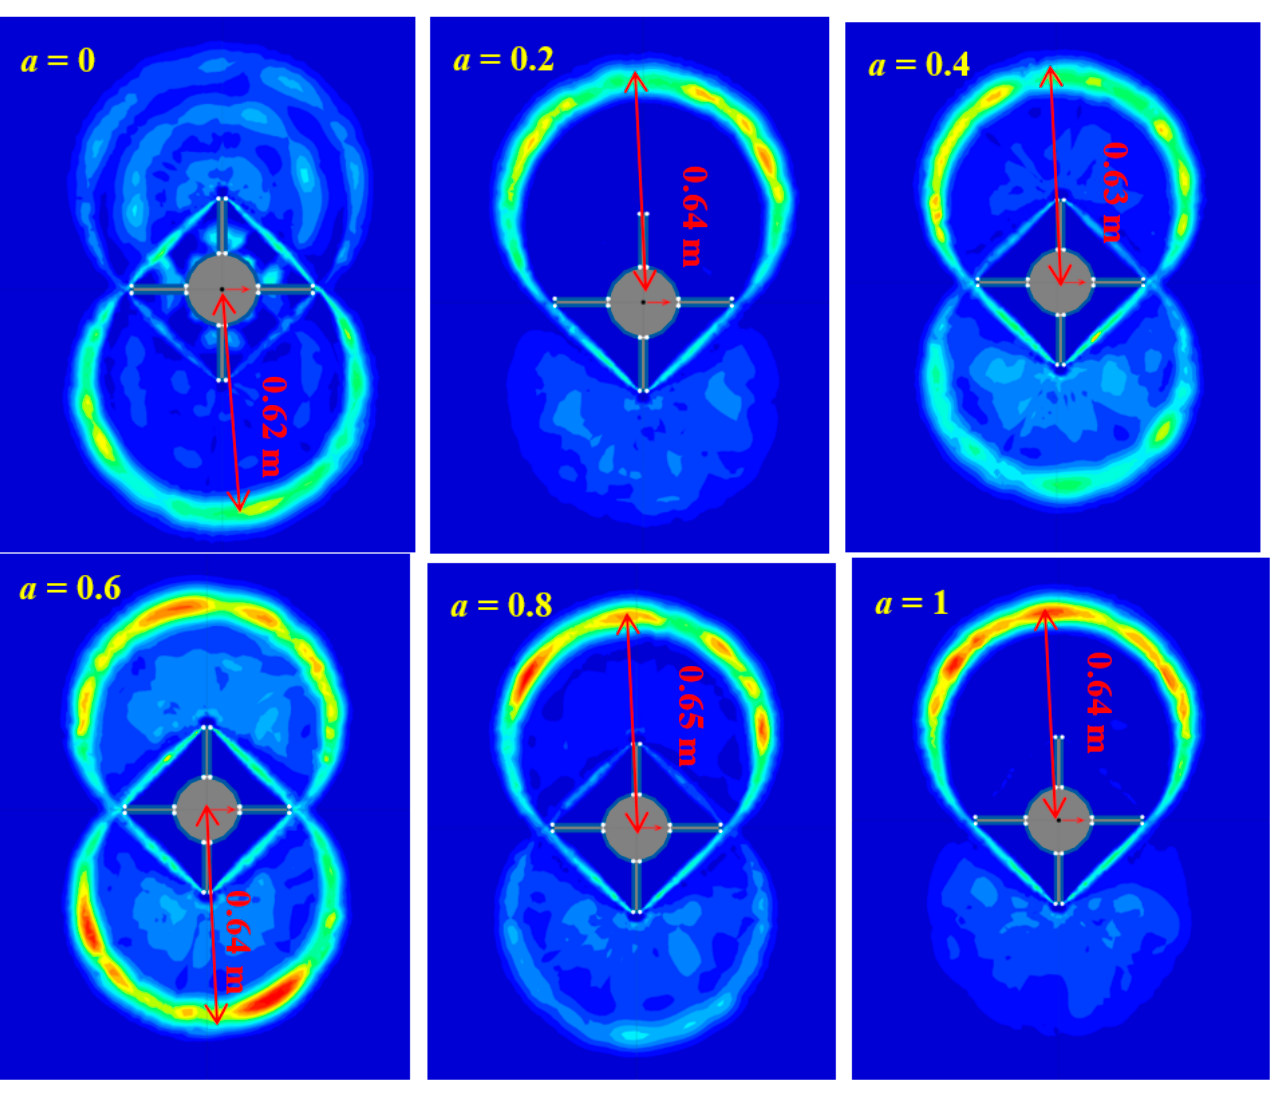
Figure 14. Influence of the different pile–soil interaction coefficients a on the shear plastic zone of the soil around the four-wing pile when lateral-load angle β = 0 and wing–diameter ratio D e / B w = 3.3.